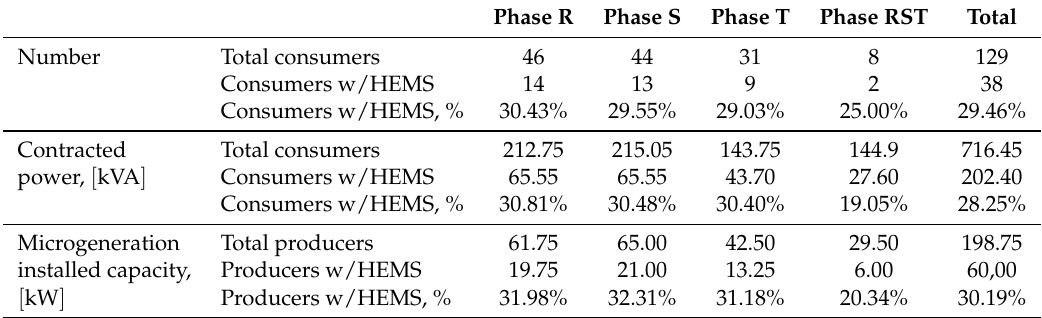
Table 3. Network characterization. Summary of the number, contracted power and of consumers with and without Home Energy Management System